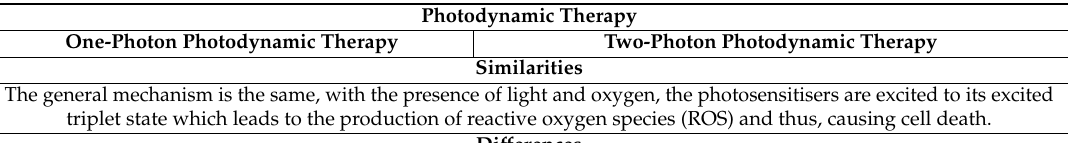
Table 2. Comparison between traditional one-photon photodynamic therapy and two-photon photodynamic